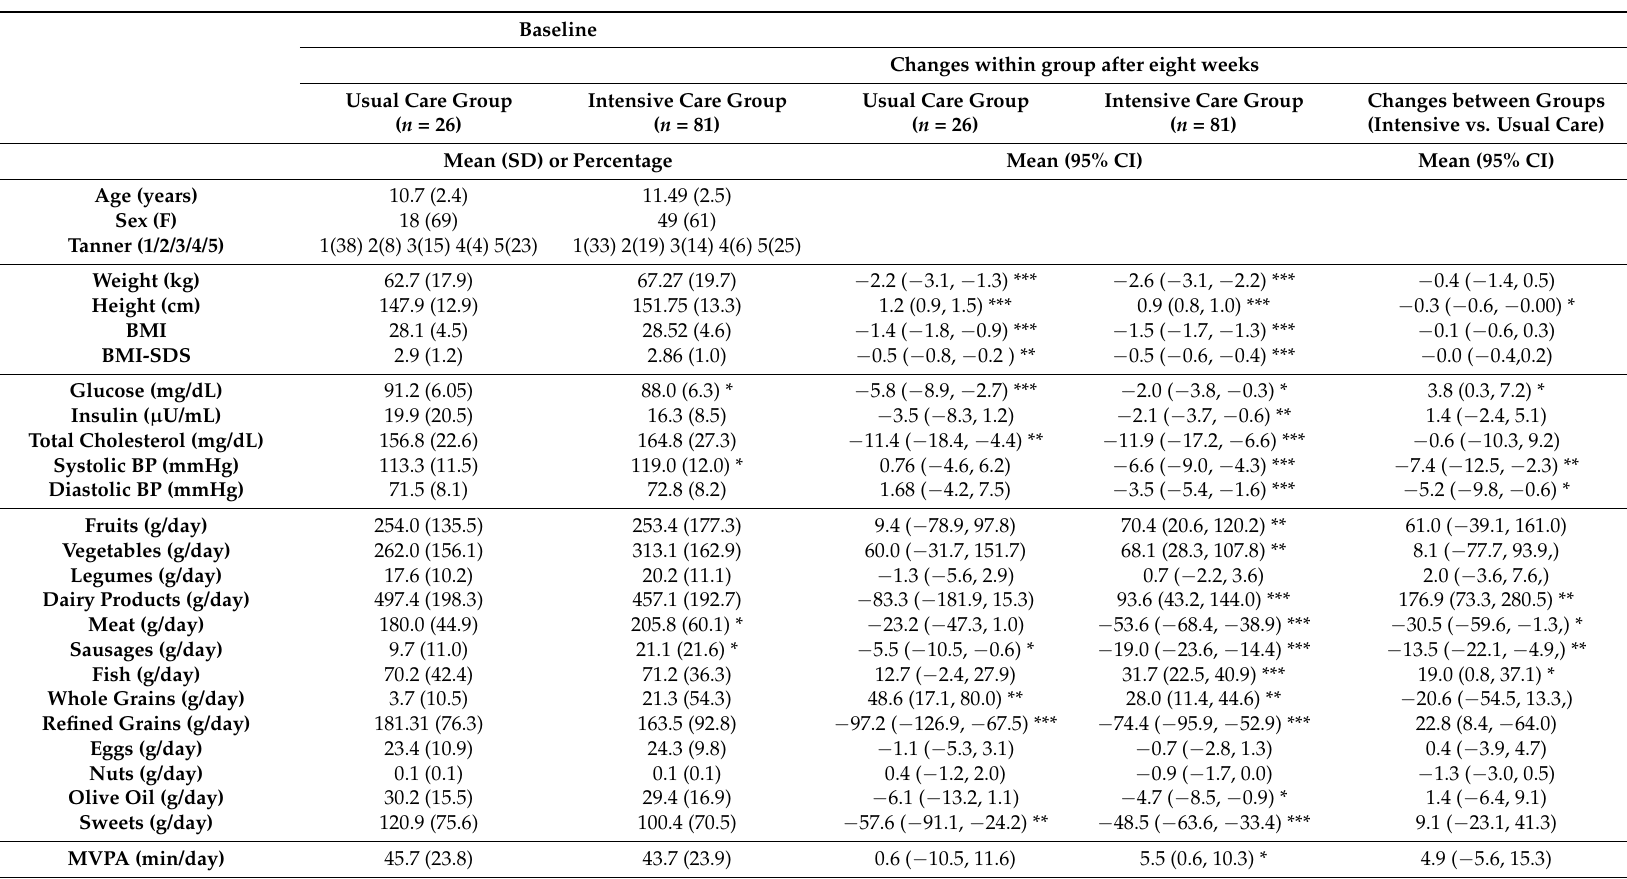
Table 1. Changes in clinical and dietary parameters after lifestyle intervention in children with abdominal